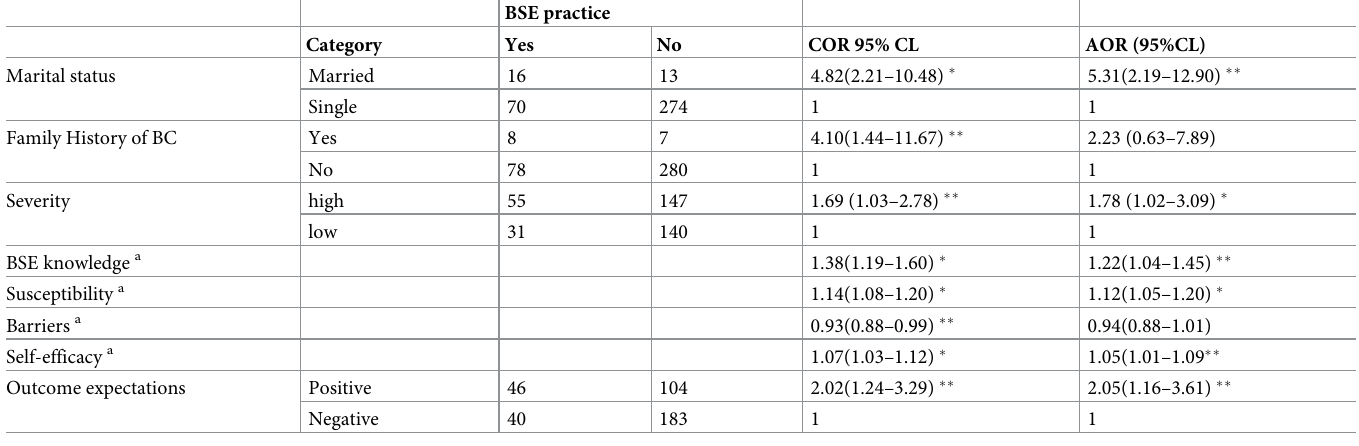
Table 6. Factors associated with breast self-examination based on multivariate logistic regression analysis among young adult women Gurage